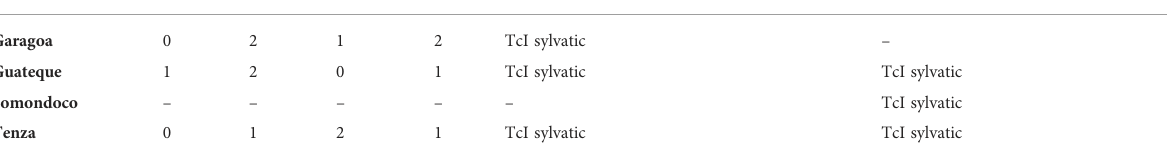
TABLE 2 Genotypes of TcI found in infected dogs and T. venosa in the study